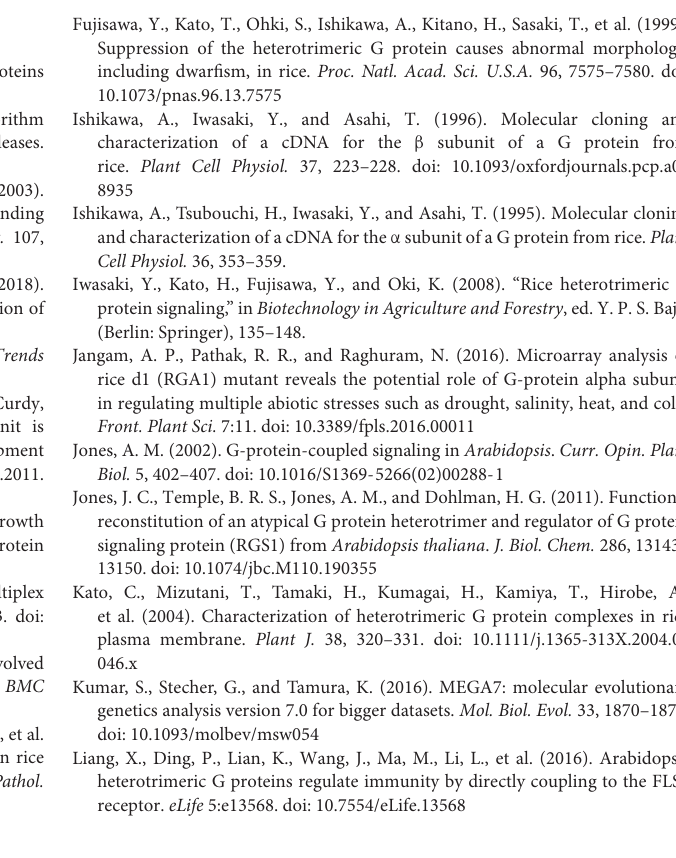
Supplementary Figure 1 | Analysis of plant phenotype and development of Osxlg mutants at different time points. Growth phenotypes of 100-day-old rice WT NIP, Osxlg single (A) , 90-day-old WT-NIP and double (B) , and 70-day-old WT-NIP and triple mutant (C) plants. Ninety-five-day-old TP309 WT rice plant was used as an additional control in (D–I) . The raw values for height and number of tillers of greenhouse grown WT rice and Osxlg mutants are shown in (D–I) , respectively. The horizontal lines indicate the means, and the error bars represent 95% confidence intervals. n = sample size. Significance p -values are expressed as